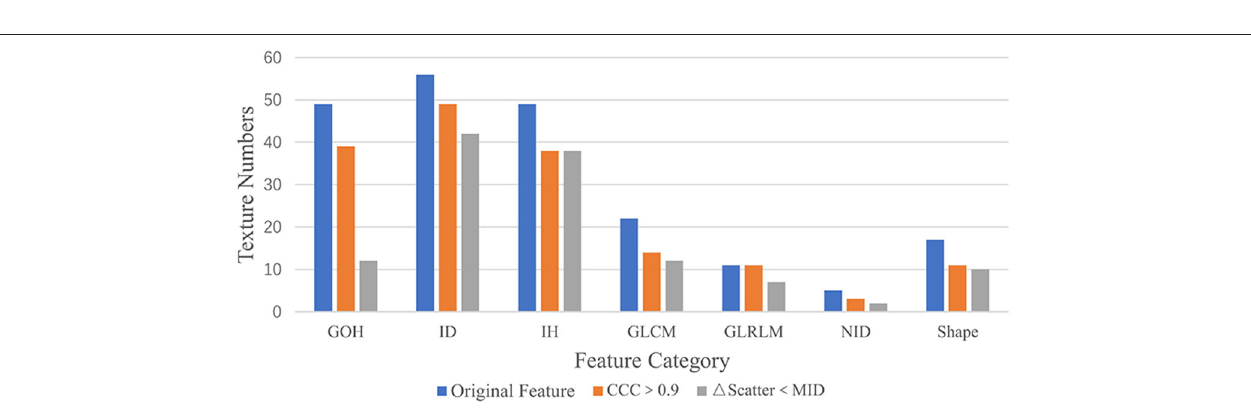
FIGURE 4 | Distribution of the CCC values for the 195 texture features extracted from the in-house texture phantoms the test–retest data.